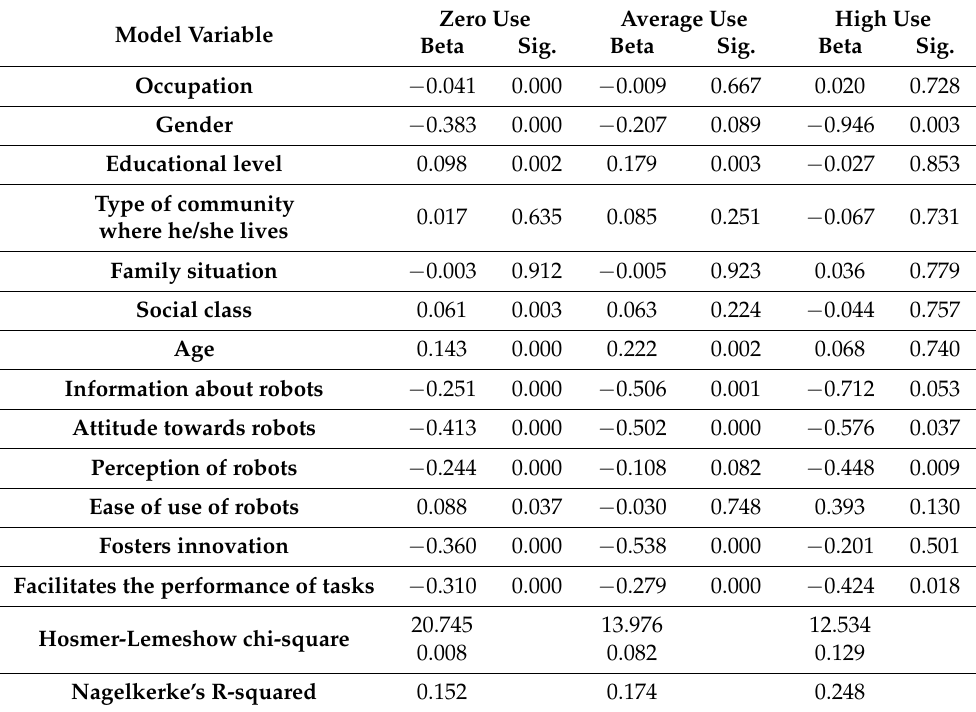
Table 4. Logit model results, by level of